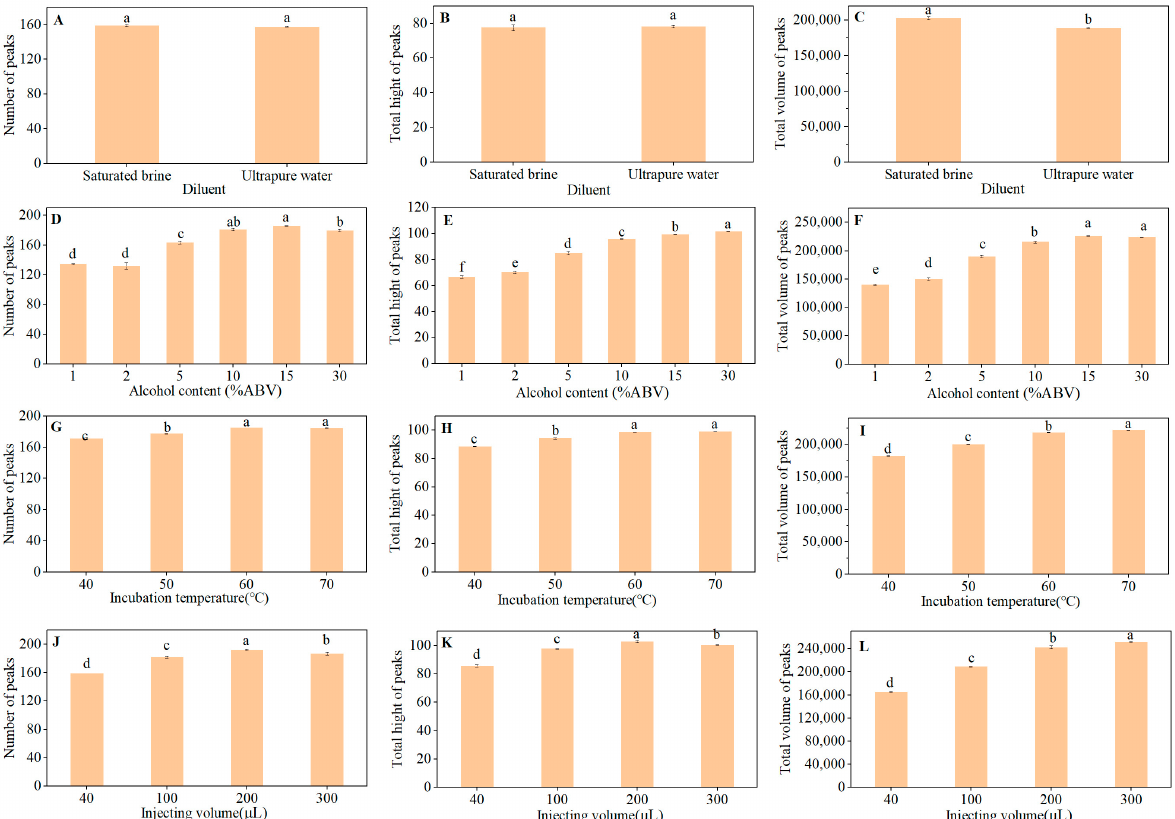
Figure 1. Number, total height, and total volume of signal peaks affected by diluent ( A – C ), alcohol content ( D – F ), incubation temperature ( G – I ), and injection volume ( J – L ). (Fisher’s LSD, significance level of 0.05.)